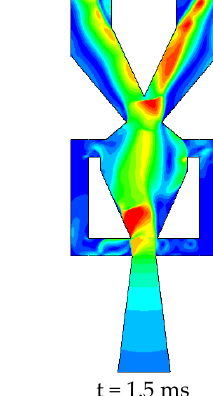
Figure 9. Mach number distributions at different times in model M 8, 12.